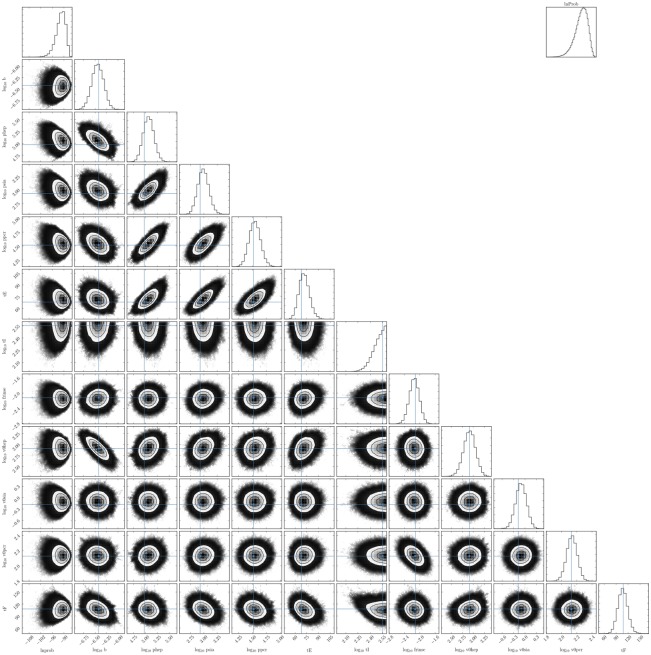
Pairwise PostPLDs for the infection resistance MM.